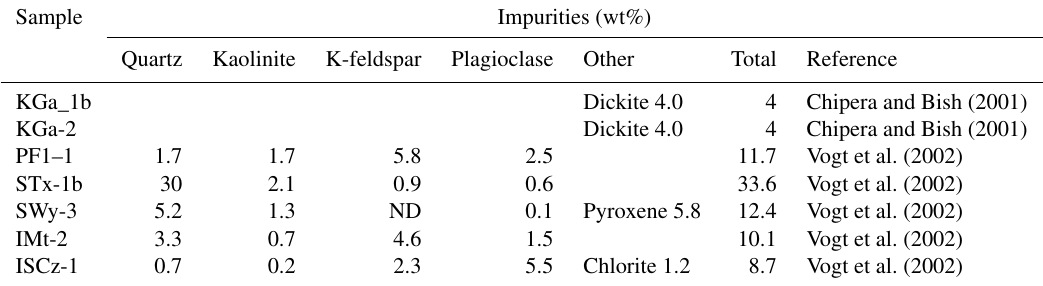
Table 3. Minerological impurities in CMS clay as determined by X-ray diffraction.